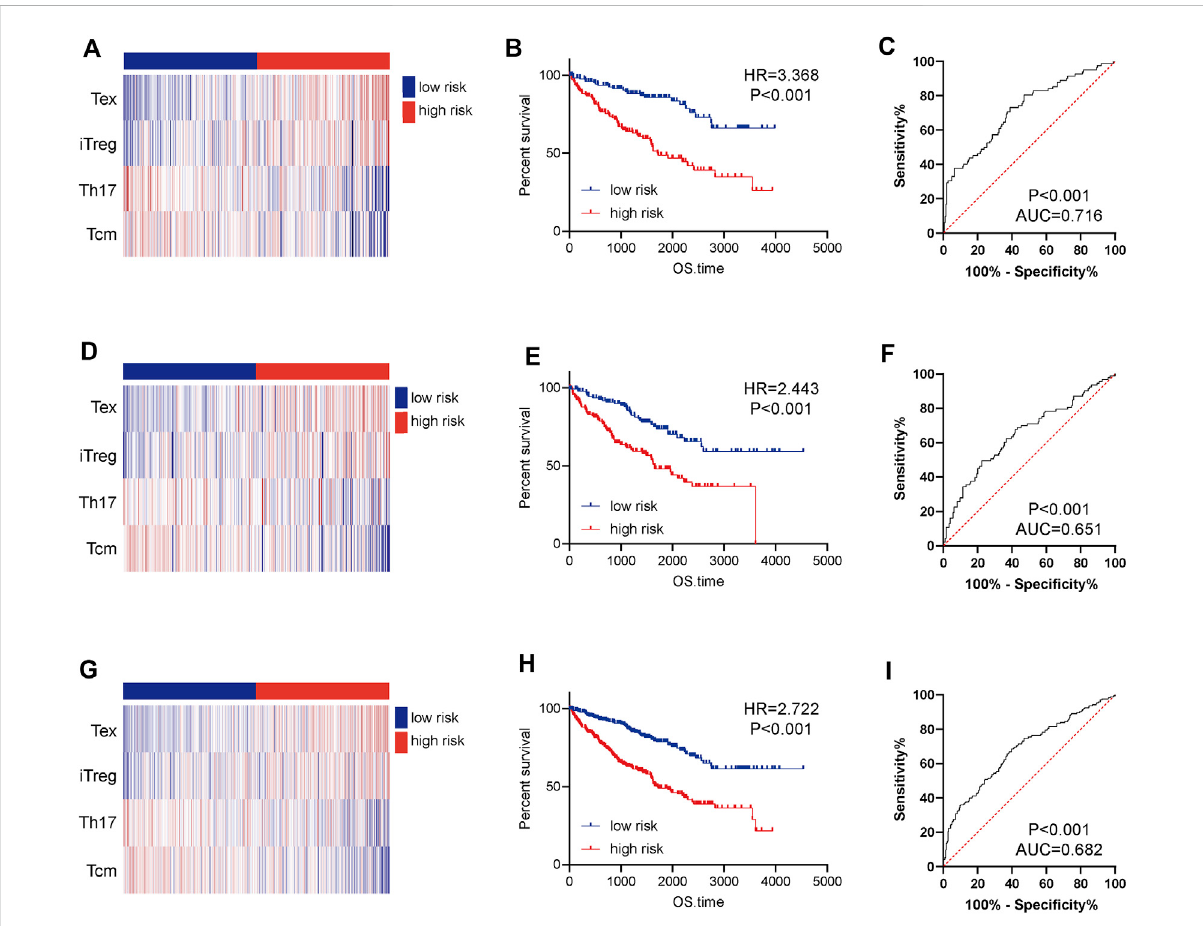
FIGURE 5 Constructionandvalidationofa4-TIICprognosticsignatureforccRCC.Theheatmapshowedthein fi ltratingabundanceoffourTIICsinthelow and high-risk groups in (A) the training cohort, (D) the testing cohort, and (G) the entire cohort. Patients in the high-risk group exhibited worse prognosisthanthoseinthelow-riskgroupin (B) thetrainingcohort, (E) thetestingcohort,and (H) theentirecohort.Signi fi cancewascalculatedwith log-rank analysis. ROC analysis of the 4-TIIC signature in (C) the training cohort, (F) the testing cohort, and (I) the entire